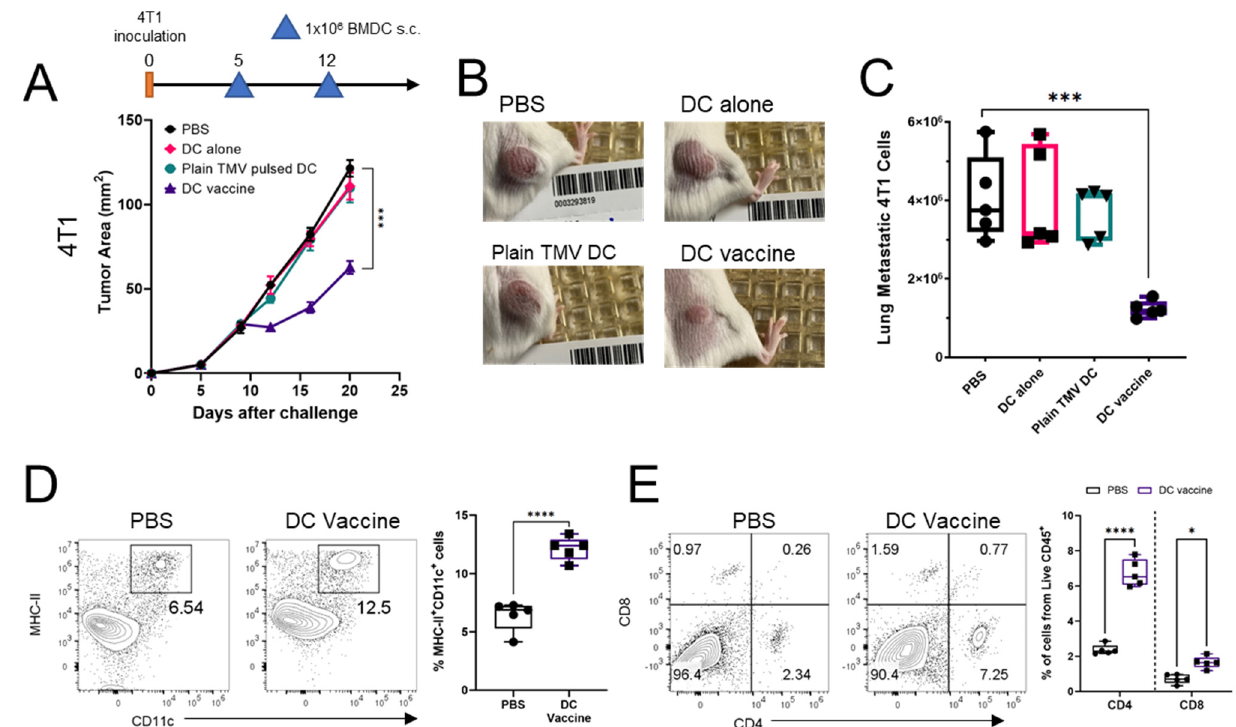
Figure 5. DC vaccine inhibits tumor growth, reduces lung metastasis, and increases immune cell infiltration into 4T1 tumors. ( A ), BALB/c mice ( n = 5 per group) were inoculated with 5 × 10 4 4T1 cells s.c. on the flank. DCs were pulsed for 24 h with 4T1 TMV (Plain TMV pulsed DC), or 4T1 TMV incorporated with GPI-IL-12 and GPI-GM-CSF (DC vaccine) and administered at days 5 and 12 s.c. on the contralateral flank at (1 × 10 6 DCs/dose). ( B ), pictures of tumors from A at day 20. ( C ), lungs were harvested at day 20 and prepared into single cell suspension then grown in selection media containing 6-thioguanine to quantify metastatic 4T1 cells. ( D ), contour plots and quantification of MHC-II + CD11c + DCs from CD45 + cell in 4T1 tumors. ( E ), contour plots and quantification of CD4 + and CD8 + T cells from CD45 + cells in 4T1 tumors. p < 0.05 *, p < 0.001 ***, p < 0.0001 ****. ( A ) was analyzed with a two-way ANOVA with Tukey’s post-test for multiple comparisons, error bars represent SEM. ( C – E ) were analyzed with a one-way ANOVA with Tukey’s post-test for multiple comparisons.